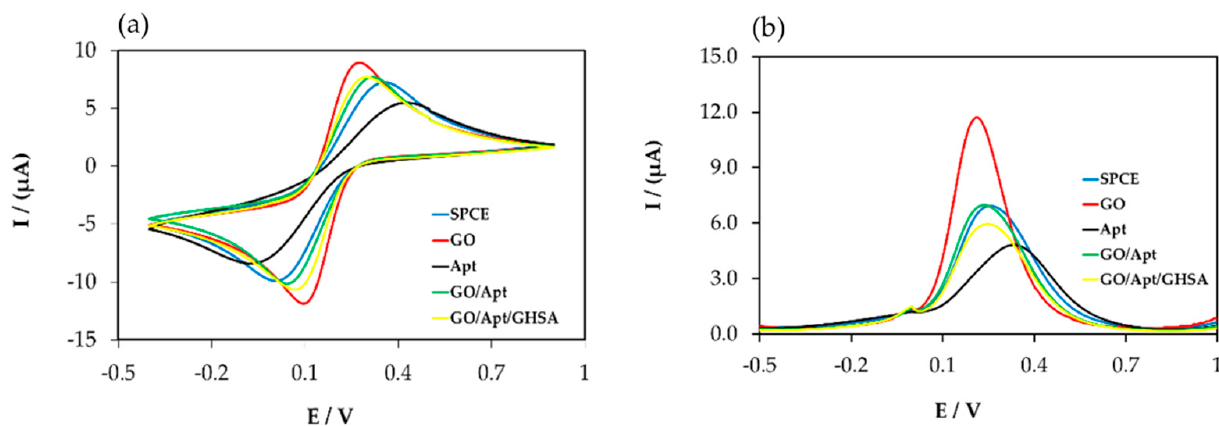
Figure 2. Electrochemical data for the components in the developed electrochemical aptasensor platform for GHSA detection using cyclic voltammetry (CV) measurement ( a ) and square wave voltammetry (SWV) measurement ( b ). The blue line (SPCE) represents the signal from the bare electrode, the red line (GO) represents the signal after adding free GO on the electrode surface, the black line (Apt) represents the signal after adding free aptamer on the electrode surface, the green line (GO/Apt) represents the signal after adding the GO-aptamer complex on the electrode surface, and the yellow line (GO/Apt/GHSA) represents the signal after adding the mixture of the GO-aptamer complex and GHSA.